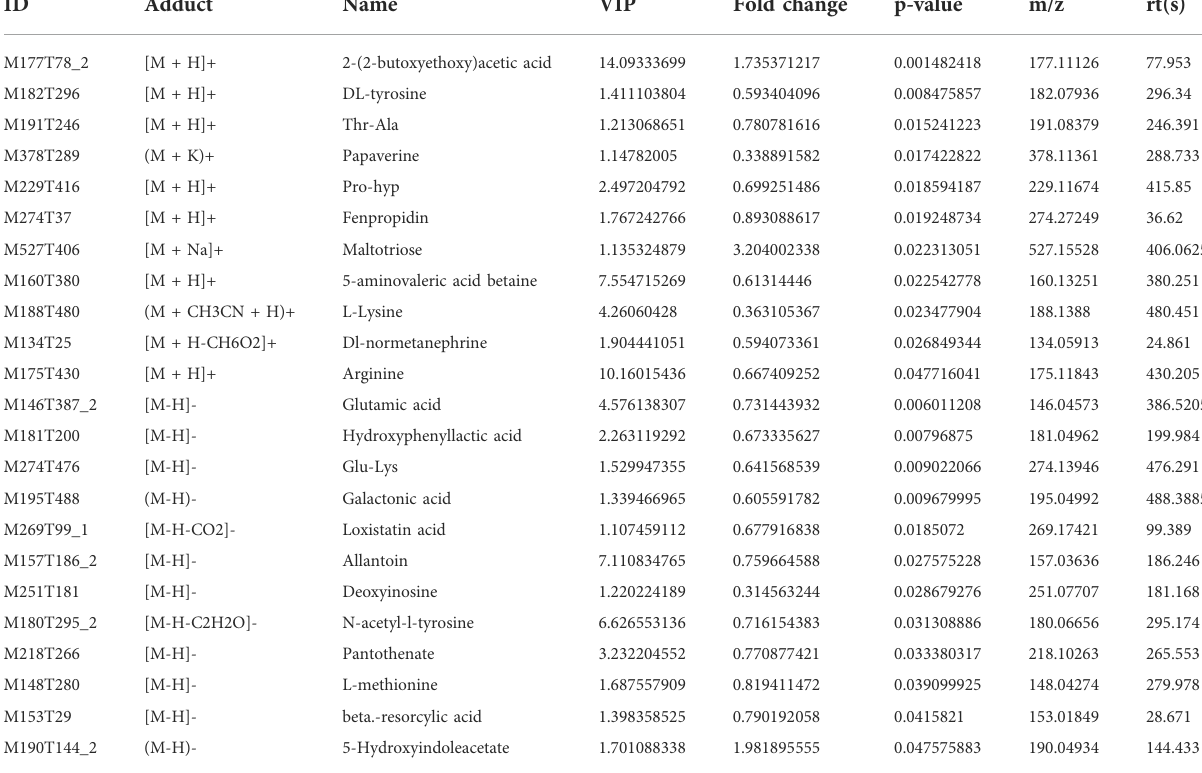
TABLE 2 Differential metabolites in positive and negative ion patterns. Between the ZHTC group and the Model